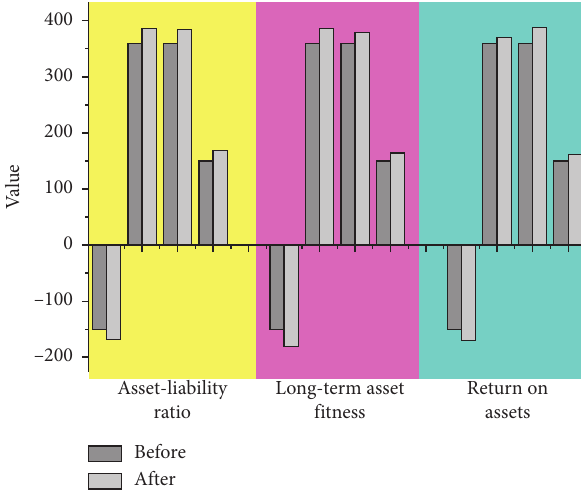
Figure 9: Initial fuzzy parameters and fuzzy parameters after training.